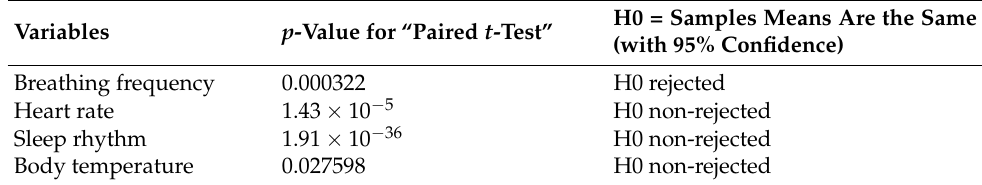
Table 10. Result of difference of means